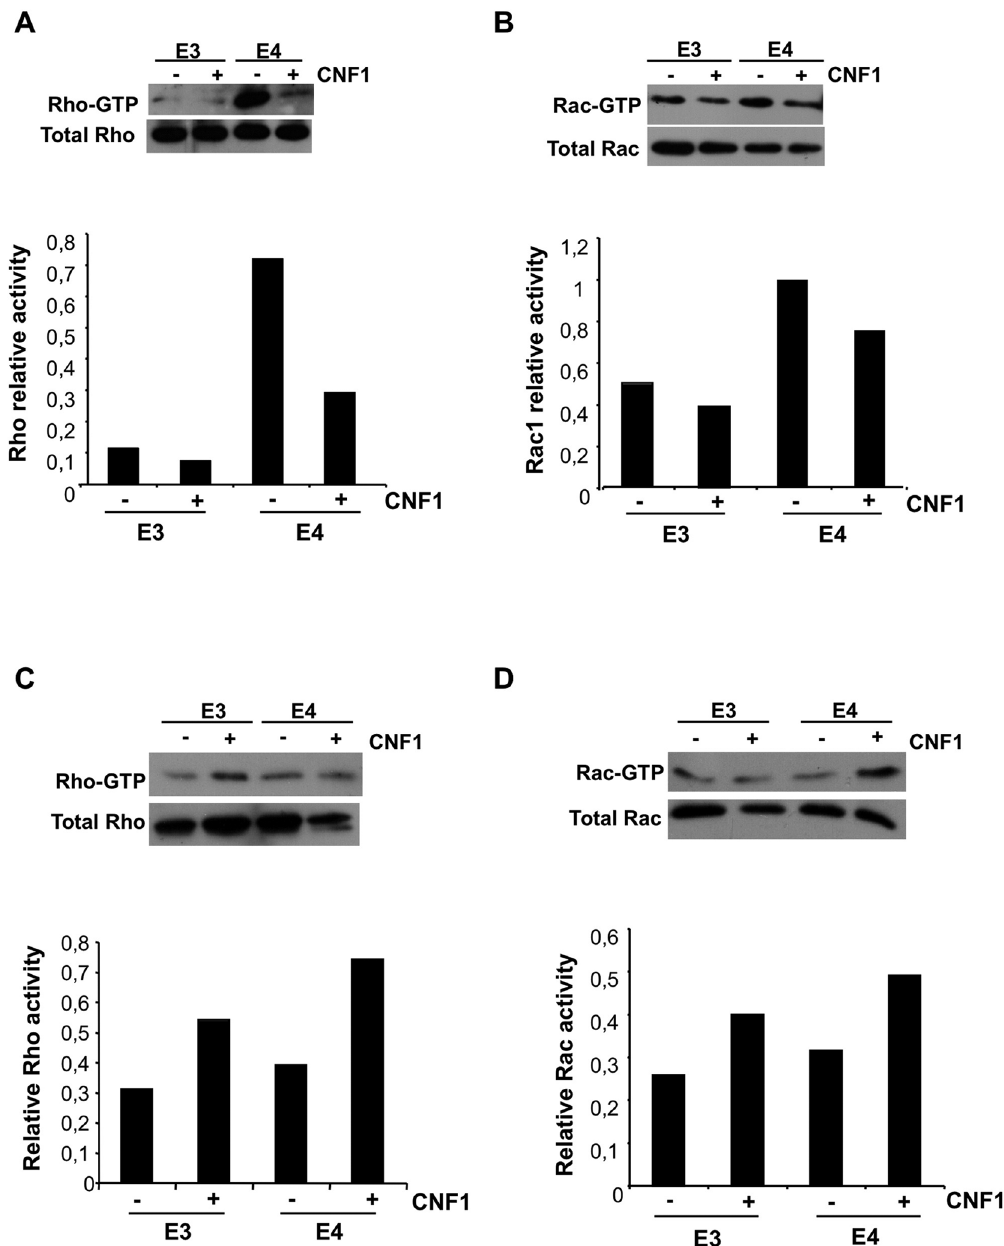
Figure 3. Modulation of Rho GTPases ’ activity by CNF1 in hippocampus and frontal cortex. Immunoblots showing representative Pull down experiments (upper panels) were normalized as a function the total proteins loaded in the assay and the results expressed as relative activity (histograms, bottom panels). A, B. Pull down of Rho-GTP (A) and Rac-GTP (B) in hippocampus. C, D. Pull down of Rho-GTP (C) and Rac-GTP (D) in frontal